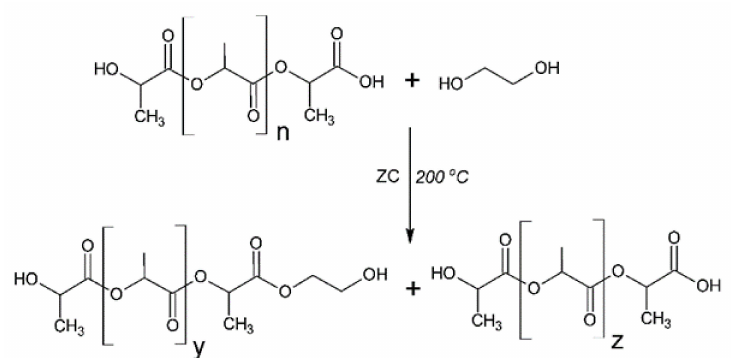
Figure 12. Scheme of synthesis of eco-polyol based on PLA waste (n = y + z).